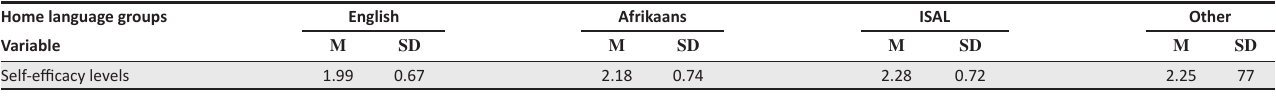
TABLE 4: Means and standard deviations for students’ self-efficacy levels in relation to their home language. Home language groups English Afrikaans ISAL